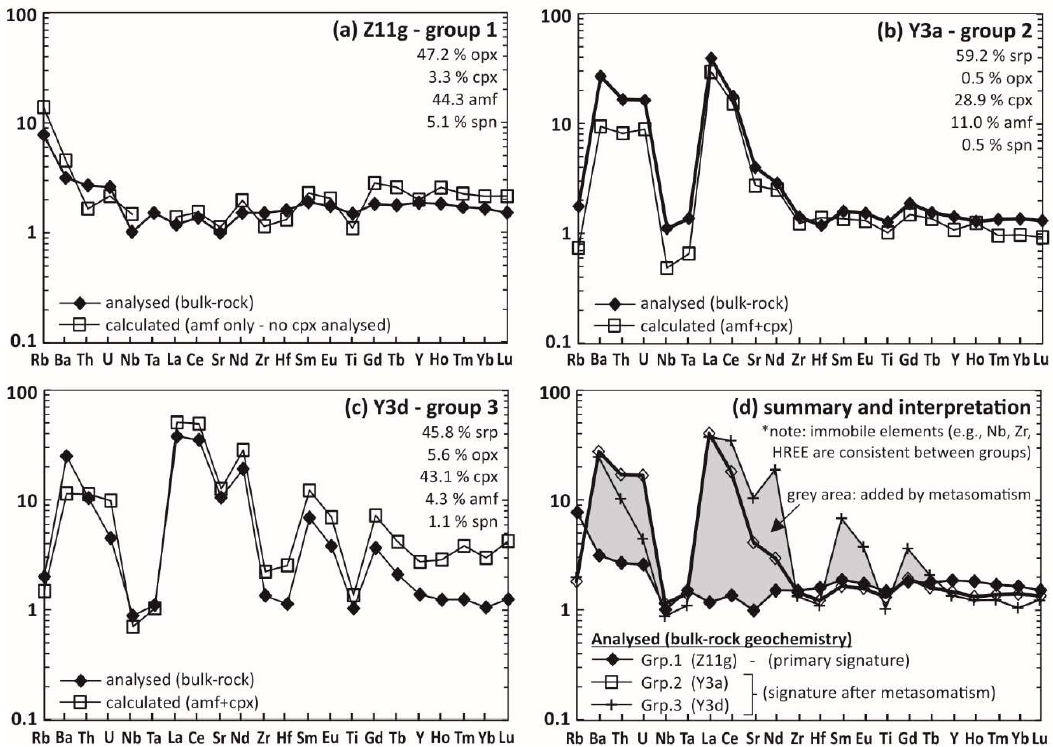
Figure 15. ( a – c ) Primitive mantle-normalised [88] trace-element plots displaying the mass balance calculations for the Ben Strome ultramafic rocks; ( d ) Primitive mantle-normalised trace-element plot detailing an interpretation of the 3 patterns displayed in parts ( a – c ).